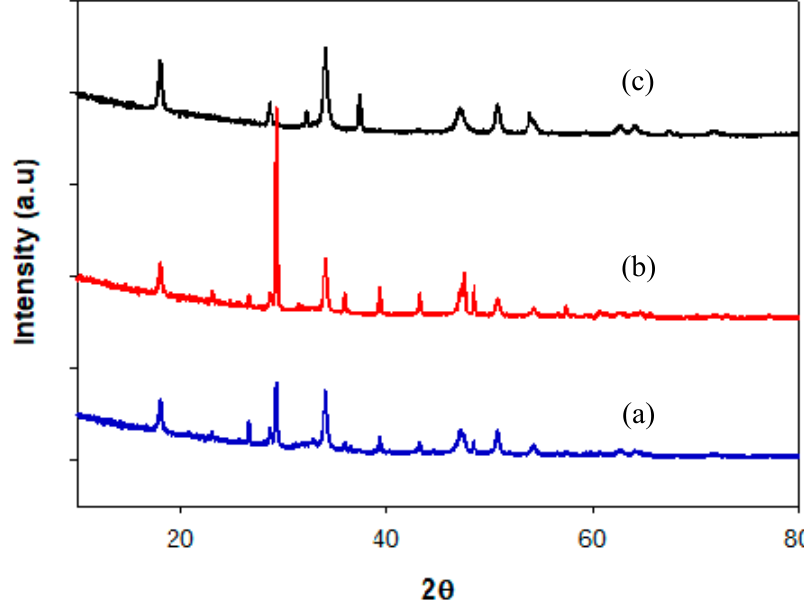
Figure4. XRDpatternofcatalystCaO / PMFAcalcinatedat900 ◦ Cwithvariousdehydrationtemperatures Figure 4. XRD pattern of catalyst CaO/PMFA calcinated at 900 °C with various dehydration of ( a ) 500, ( b ) 600, and ( c ) 700 ◦ C for 3 temperatures of ( a ) 500, ( b ) 600, and ( c ) 700 °C for 3 h.